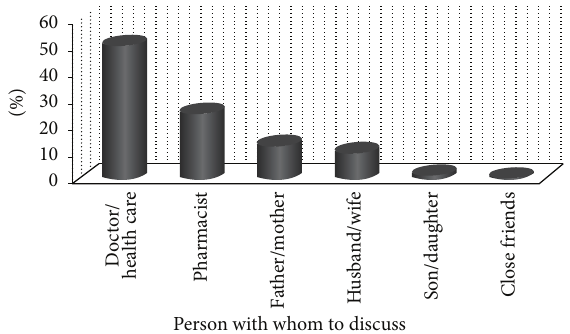
Figure 2: Percentage distribution of respondents to discuss their problem on TB infection.